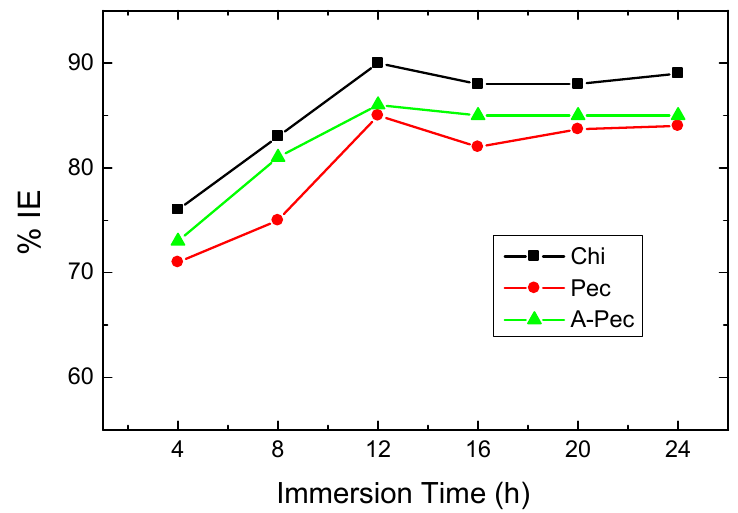
Figure 11. Graphs of the change in %IEs of 500 ppm of the examined carbohydrate polymers with time of immersion for mild steel in 0.5 M HCl at 303 K.